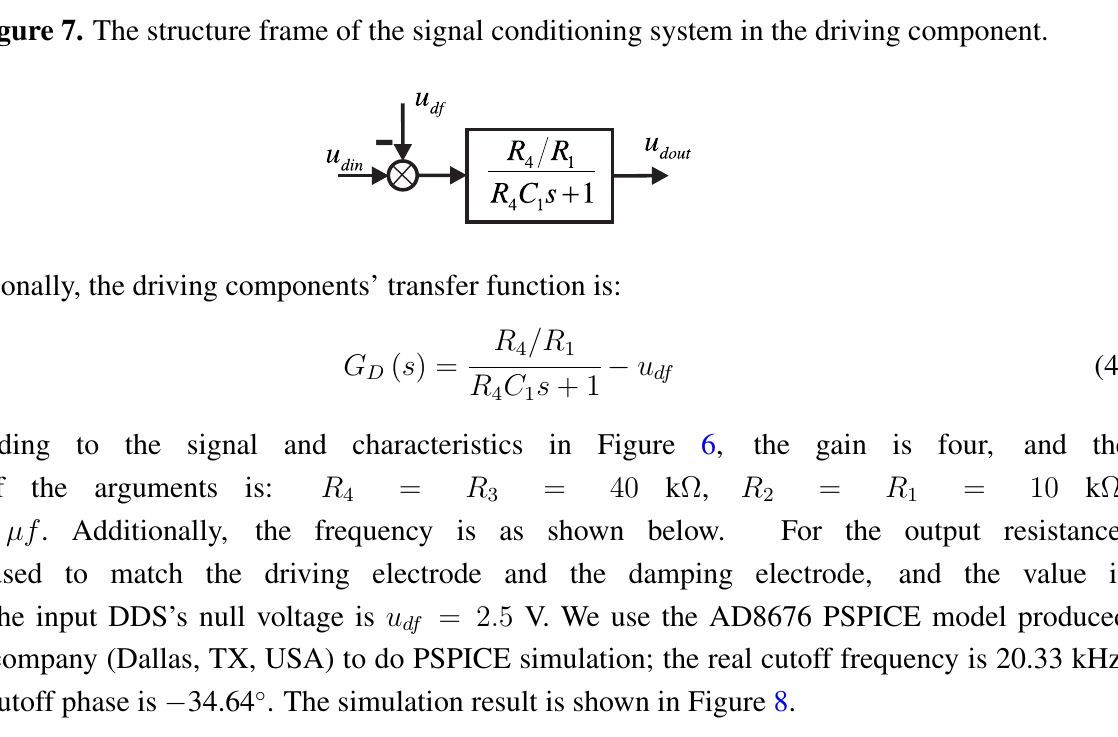
Figure 7. The structure frame of the signal conditioning system in the driving component.